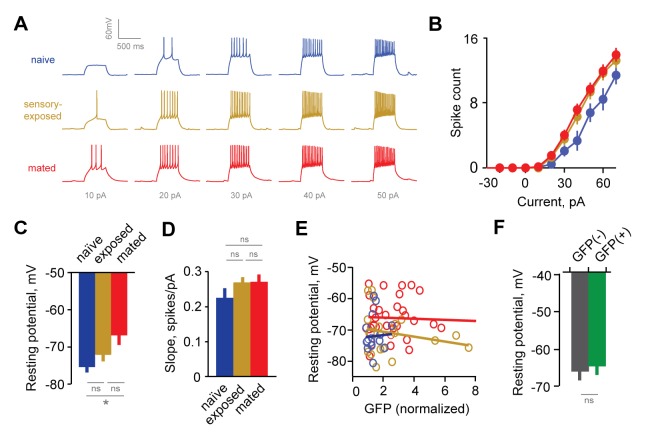
Experience alters intrinsic excitability of interneurons.(A) Representative responses to graded current injection for GCs from naïve, sensory-exposed and mated mice. (B) Current-firing plot shows a shift towards increased excitability of GCs from both mated and sensory-exposed females. (C) GC resting membrane potential was significantly hyperpolarized after mating (p=0.008 for mated vs. naïve; ANOVA with post-hoc Tukey test; F = 5.18; Fc = 3.14; n = 17, 19, and 31 cells from 5, 9, and 12 mice for naïve, sensory-exposed, and mated groups respectively). (D) The slope of the current-firing function was similar across groups (0.28 ± 0.01, 0.27 ± 0.02, and 0.28 ± 0.01; F = 0.14; Fc = 3.15; p=0.87; ANOVA with post-hoc Tukey test). (E) GC resting potential was uncorrelated with intensity of Arc-GFP labeling in both sensory-exposed and mated animals (slope not significantly different from zero; p=0.87, 0.37 and 0.81 for naïve, sensory-exposed and mated groups respectively; linear regression test; n = 17, 19 and 31 cells in 5, 9 and 12 mice). (F) In mated females, resting potential was indistinguishable between GFP(-) and GFP(+) GCs (−66.8 ± 2.19 vs. −65.4 ± 1.85 mV respectively; p=0.62, t-test; n = 10 and 13 cells in 10 mice, subdivided from the mated group in panel E). NS, not significant; *p<0.01.DOI:
http://dx.doi.org/10.7554/eLife.25421.01410.7554/eLife.25421.015Figure 4—source data 1.This spreadsheet contains the resting membrane potential and firing rate data for the individual neurons used to generate the bar plots shown in Figures 4C, D and F.These data can be opened with Microsoft Excel or with open-source alternatives such as OpenOffice.